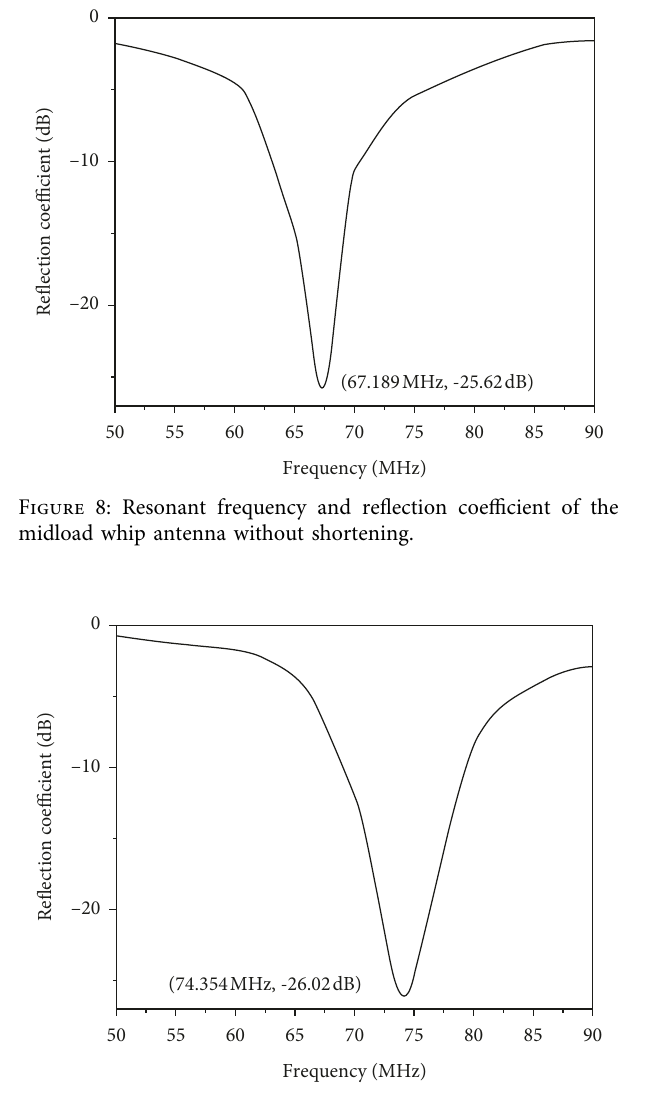
Figure 9: Resonant frequency and reflection coefficient of the midload whip antenna with shortening. Table 1: Comparison of field strengths received by receivers at different